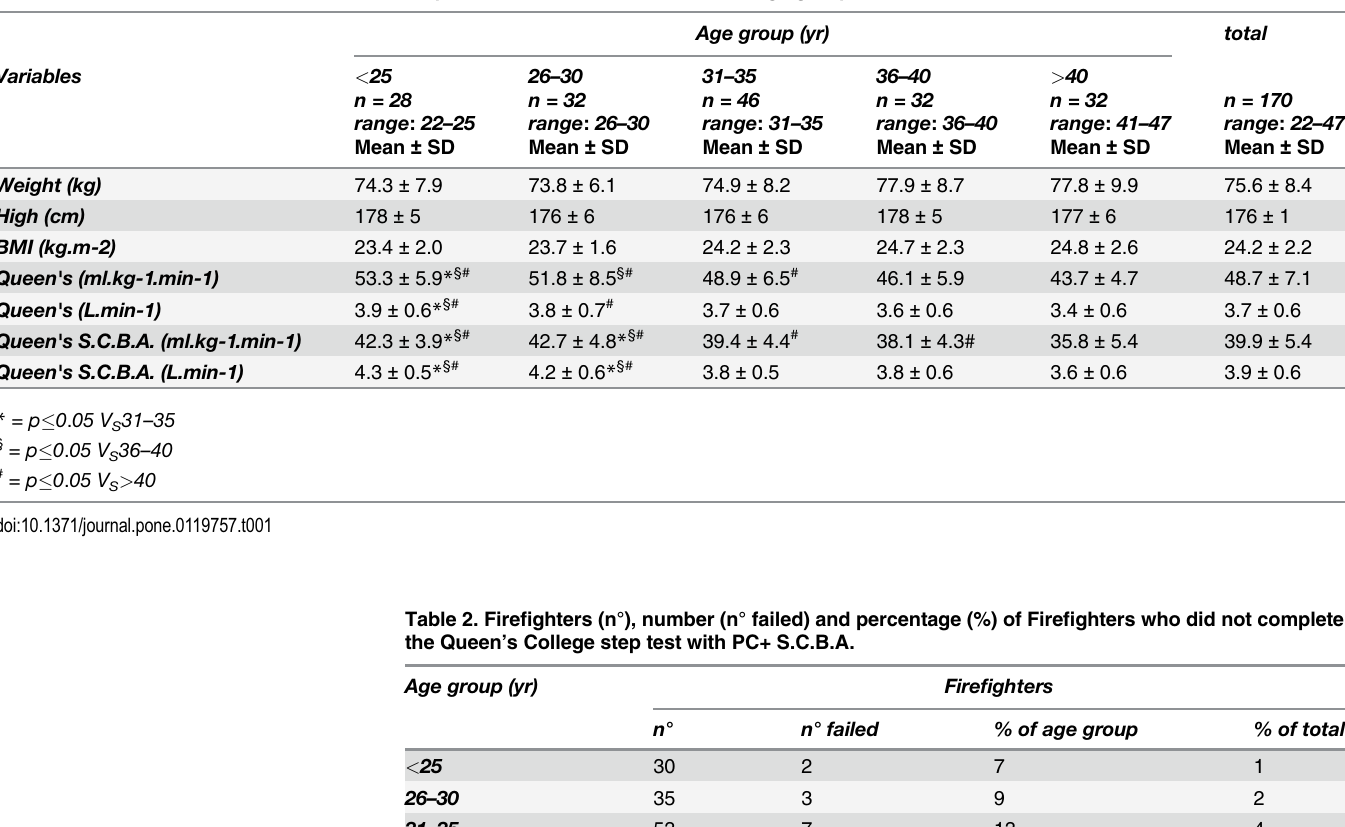
Table 1. Means ± standard deviations of anthropometric and aerobic data across age group.